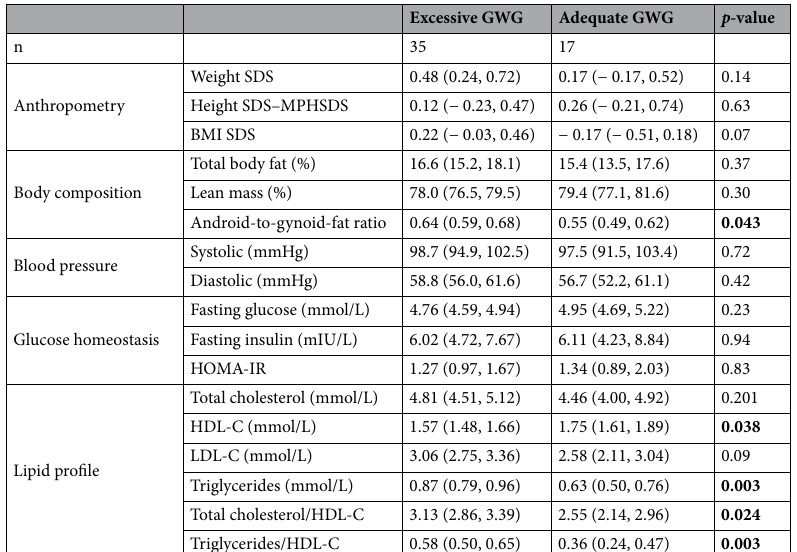
Table 6. Clinical outcomes at the 7-year follow-up in the offspring according to maternal gestational weight gain. Data are model-adjusted means and the respective 95% confidence intervals (CI) derived from general linear models, including maternal body mass index (BMI) in mid-gestation, adjusted for child’s sex, age, and trial group allocation. HDL-C, high-density lipoprotein cholesterol; HOMA-IR, homeostatic model assessment of insulin resistance; LDL-C, low-density lipoprotein cholesterol; MPHSDS, mid-parental height standard deviation score; SDS, standard deviation score. p -values for statistically significant differences between the two groups (at p < 0.05) are shown in bold.